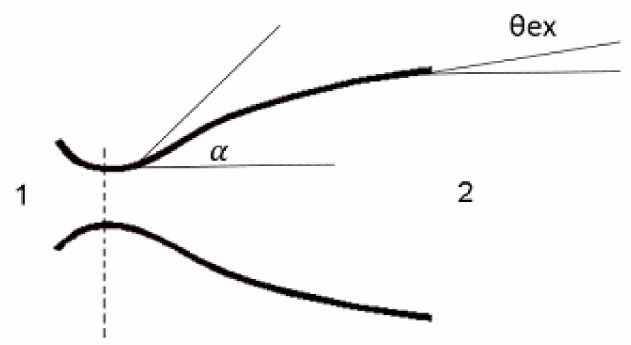
Figure 8. Bell nozzle